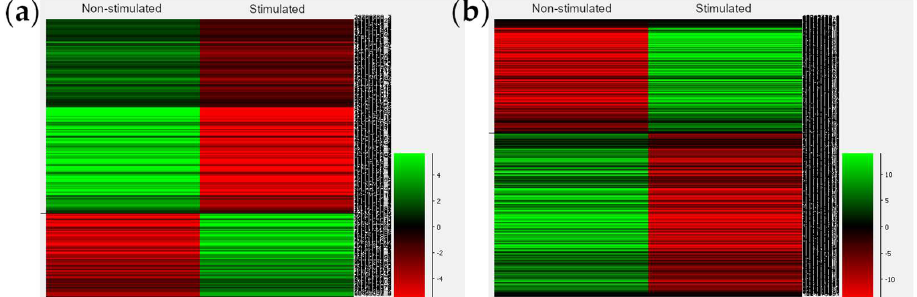
Figure 5. ( a ) Heatmap for oocyte 256 DMRs between oocytes from non-stimulated and stimulated cows using the 21 best-covered libraries and considering the animals as biological replicates after segmenting the genome in methylated and unmethylated domains; ( b ) Heatmap for oocyte 5220 DMRs between non-stimulated and stimulated cows using the merged data sets from the three animals in one single biological replicate after segmenting the genome in methylated and unmethylated domains. On the right side of each heatmap, the scale represents the methylation status, where green corresponds to a lower methylation and red to a higher methylation. When the single-cell libraries were merged and analysed as two unique datasets from S and NS animals over the same probes (methylated and unmethylated domains), we found 5220 DMRs ( p < 0.05). The representative heatmap is shown in Figure 5b. The corresponding annotation for the DMRs with the merged (5220) and unmerged (256) datasets are shown in Supplementary Table S5. The representative scatter plot on the variation of methylated and unmethylated regions between S and NS animals is shown in Figure 6.